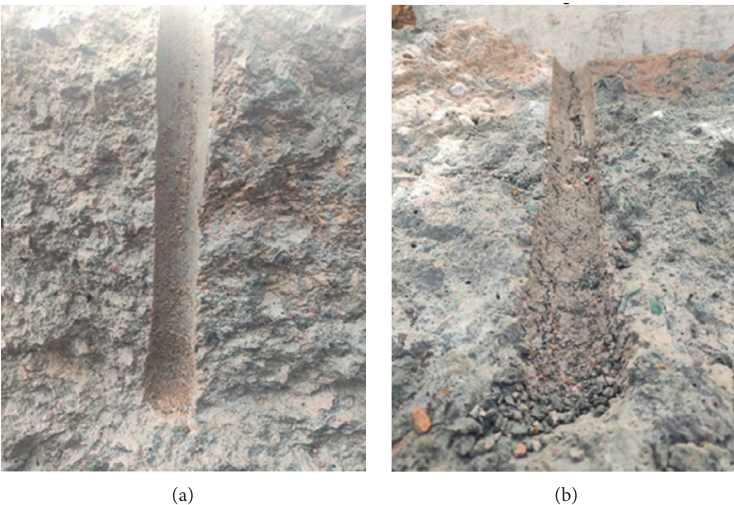
Figure 9: Cracks around the blast hole after blasting: (a) conventional blasting; (b) multidirectional shaped charge